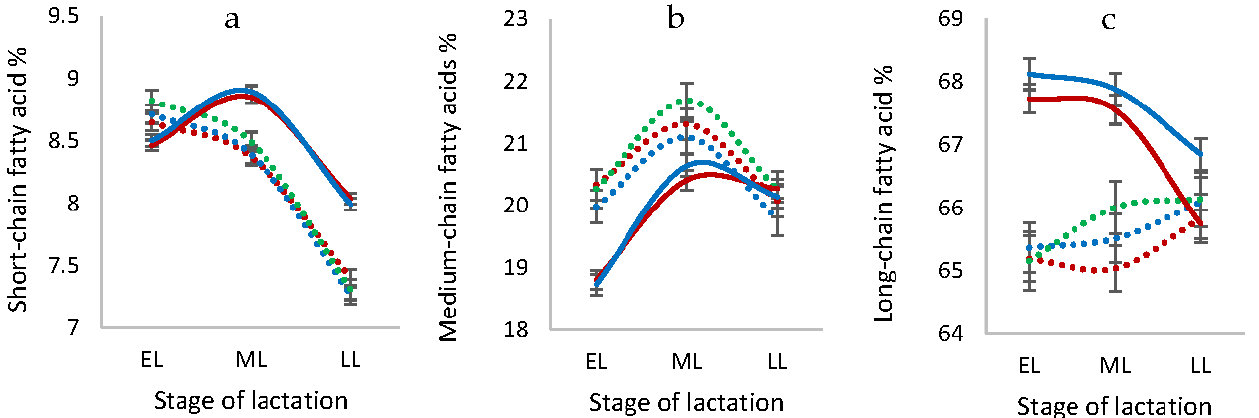
Figure 4. Concentrations of ( a ) short-chain fatty acids ( b ) medium-chain fatty acids ( c ) long-chain fatty acids in milk from Holstein-Friesian ( …. ), Holstein-Friesian × Jersey ( …. ) and Jersey ( …. ) cows milked OAD and Holstein-Friesian ( — ) and Holstein-Friesian × Jersey ( — ) cows milked TAD during the production season 2020–2021. EL = early lactation (<90 days); ML = mid-lactation (90–180 days); LL = late lactation (>180 days). The vertical bars show standard errors. Breed effect was significant for daily milk and fat yields, percentages of fat and protein, and concentration of SFA based on the F-values (Table 2). Least-squares means and standard errors for each breed within milking frequency for milk production, composition traits, and FA acid composition are presented in Table 3. In cows milked OAD, J cows showed a significantly ( p < 0.05) lower daily milk yield, protein yield, and lactose yield compared to F and F × J cows. Holstein-Friesian × Jersey cows produced a significantly higher daily fat yield. Jersey cows produced significantly higher percentages of fat and protein compared to F cows with F × J cows producing intermediate values. In cows milked TAD, F cows produced significantly higher daily milk yield and F × J cows produced significantly higher fat and protein percentages. The breed effect for most of the FA concentrations was not significant in cows milked OAD and TAD. The concentrations of SFA and C18:0 were significantly higher and the concentration of UFA was significantly lower in J cows milked OAD and F × J cows milked TAD. The results of this study have to be considered with caution due to the confounding effect of feed with milking quency.